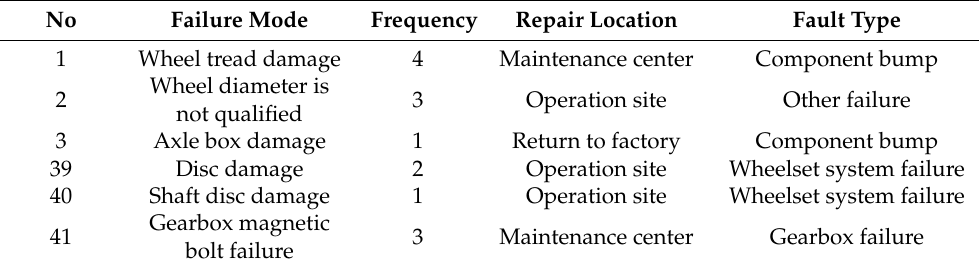
Table 1. Pre-processed maintenance data